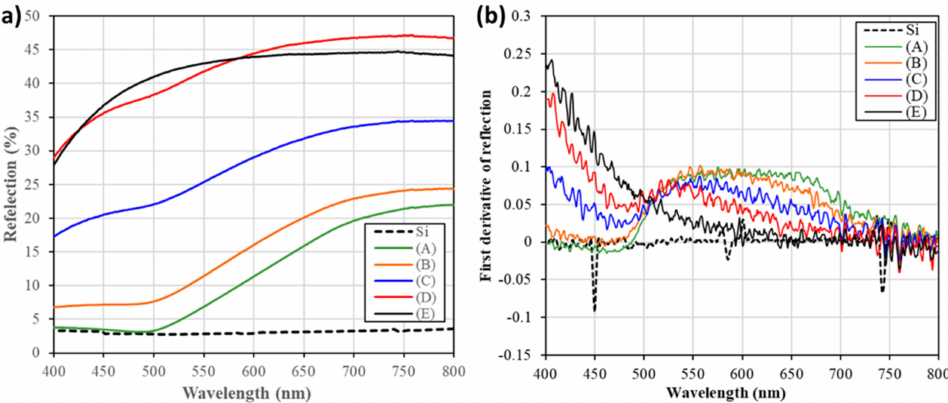
Figure 7. The ( a ) reflection and ( b ) first derivative spectra of Au@Ag–DNFs/Si samples (A–E) and the Si substrate. SERS spectra of R6G molecules (10 − 6 M) in an aqueous solution were deposited on various Au@Ag-DNFs/Si substrates Figure 8a. The prominent peaks of R6G